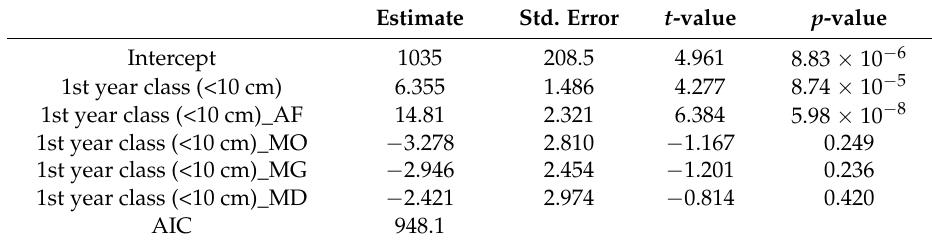
Table 1. Parameter estimates of the predictive model for the total number of removable individuals in the same cohort (first to third year individuals) as a function of the number of <10 cm individuals designated as first-year Acanthaster cf. solaris removed at each sector along the Onna Coast, Japan. AF = Afuso, MO = Minami Onna, MG = Maeganeku, MD = Maeda. p -value: significance level based on t -value.